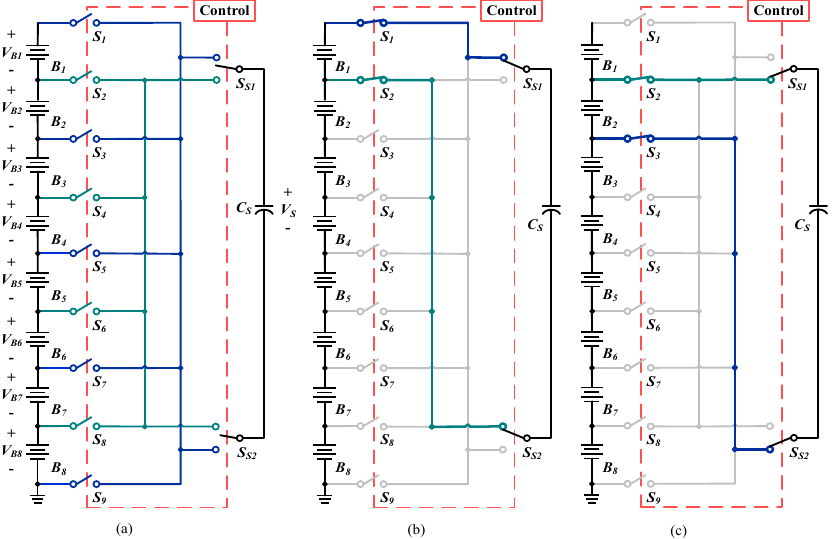
Figure 7. Single-SC-based BE*: ( a ) circuit architecture; ( b ) first state; ( c ) second state. * Eight batteries are shown as